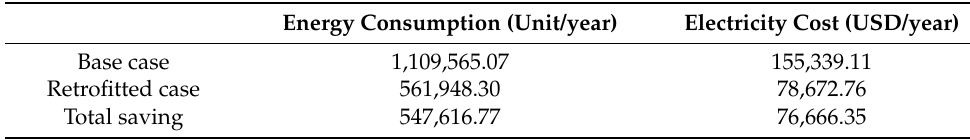
Table 21. Energy cost saving after retrofitting a building.